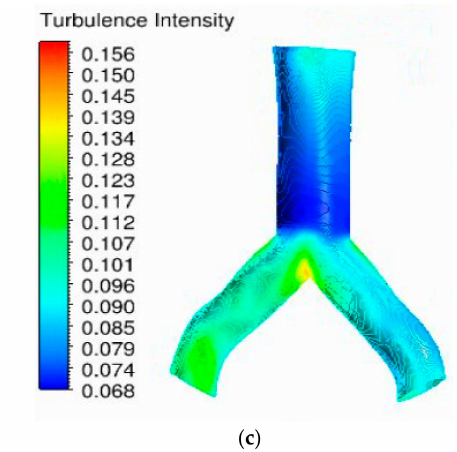
Figure 11. Turbulence intensity at 30 lpm for the healthy lung model: ( a ) whole model, ( b ) mouth–throat and trachea (intensity range rescaled), and ( c ) third bifurcation of the healthy lung.